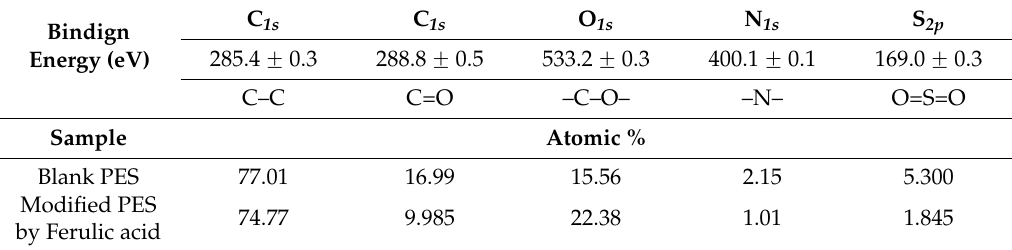
Table 1. Analysis of XPS spectra of blank and modified real PES membranes. Modification condition is